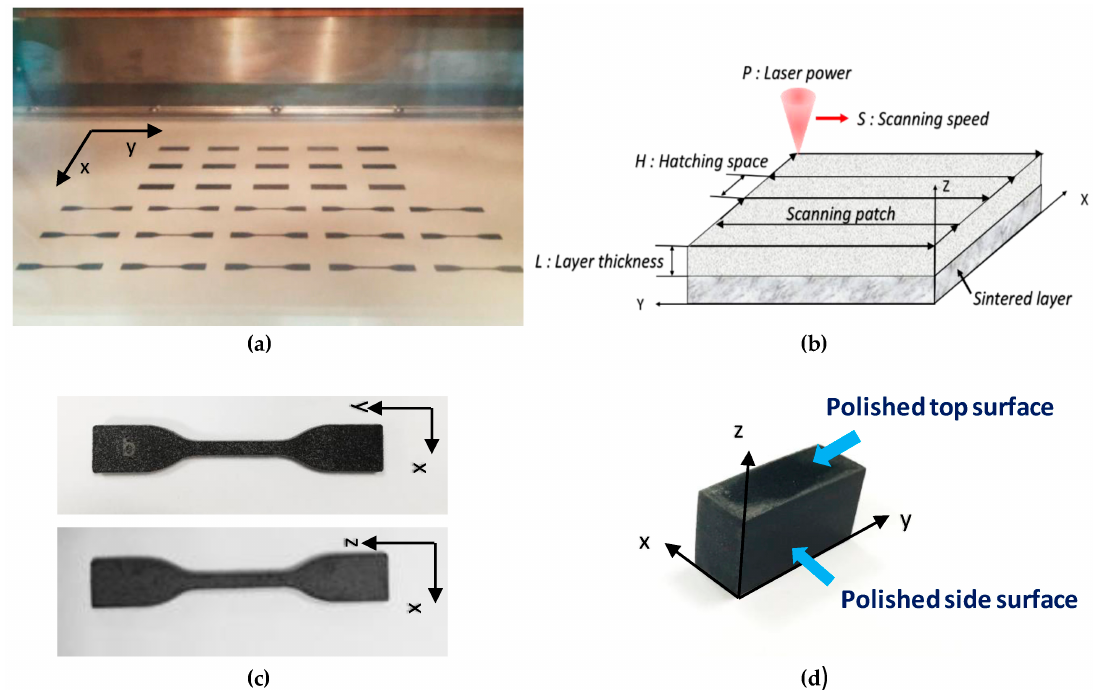
Figure 1. ( a ) building platform of EOS P395 machine regarding as the X – Y plane; ( b ) schematic illustration of the critical parameters in laser sintering process; ( c ) micro tensile specimens (ASTM D638, type IV) produced in the X – Y and X – Z planes; ( d ) the polished specimen for microstructure characterization in the X – Y (top surface) and Y – Z (side surface) planes.